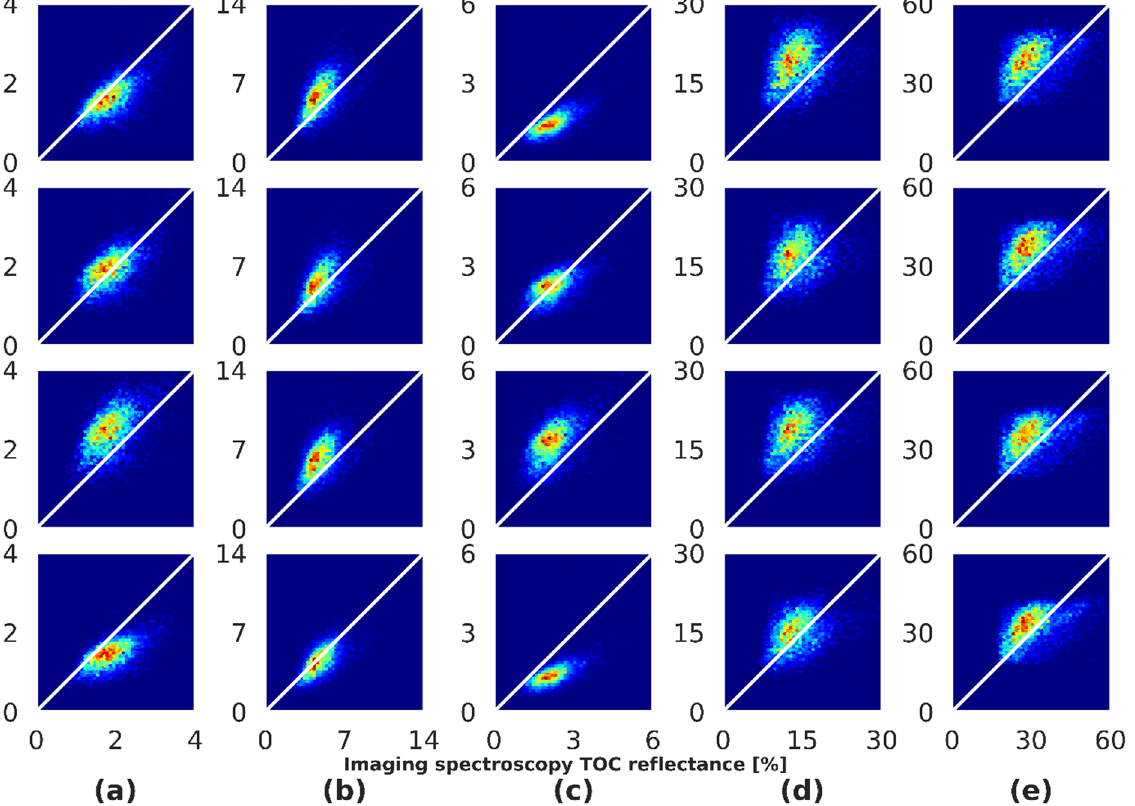
Figure 10. Spectral variation of ( a ) R 2 and ( b ) RMSE derived from NPVf Cbrown for the different scenarios accounting for LOP variability.